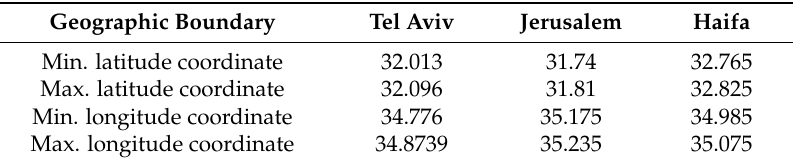
Table A1. The urban regions analyzed [13].